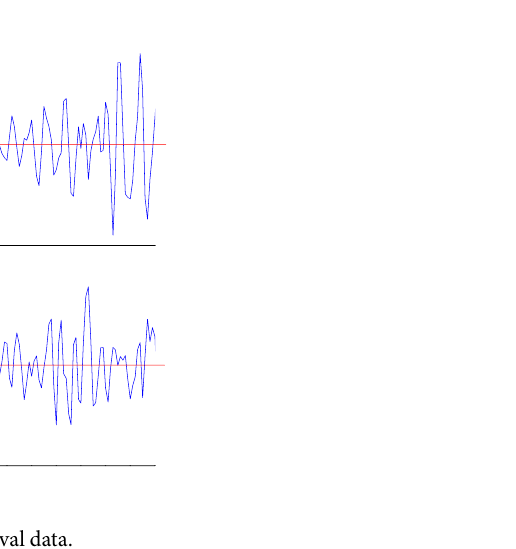
Figure 6. The results of the new and traditional methods in a 2D planar locating test.